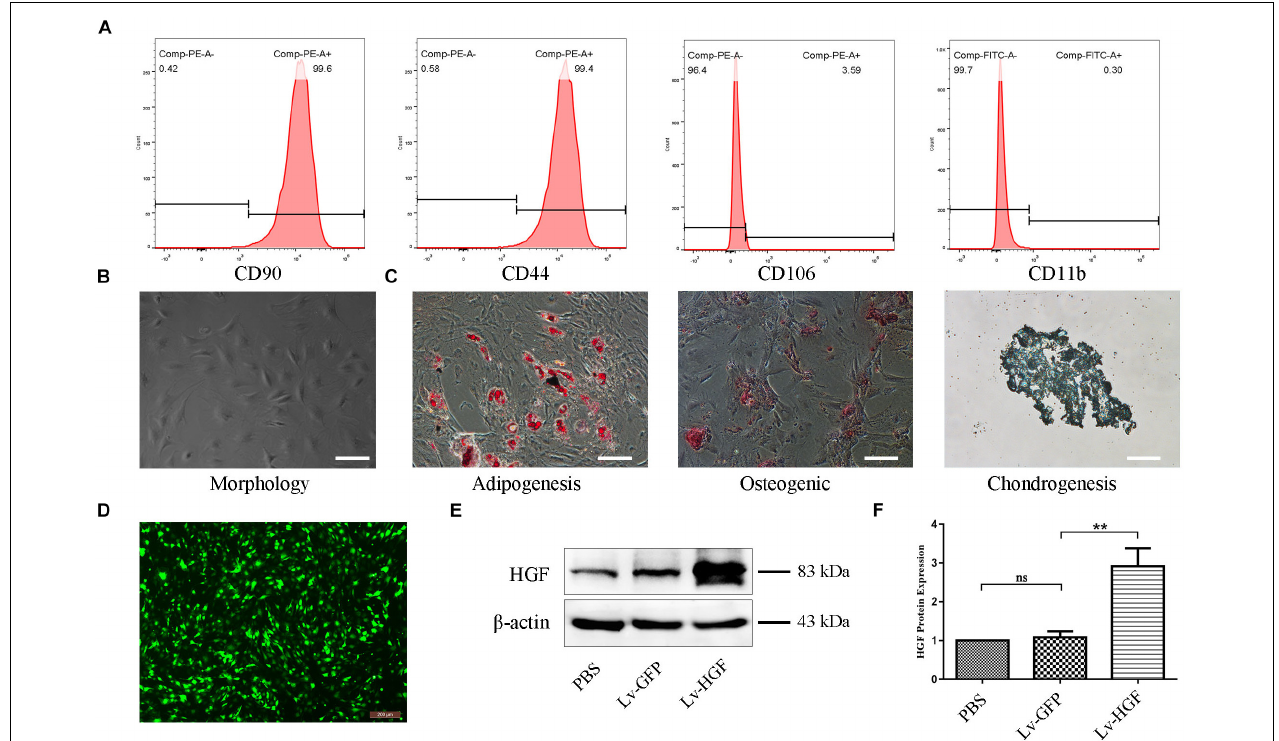
FIGURE 2 | Confirmation of TSC identity, differentiation capacity, and transduction efficiency. (A) Flow cytometric detection of cell surface markers, including CD90, CD44, CD106, and CD11b/c. (B) Typical TSC morphology. (C) Oil Red O, Alizarin Red, and Alcian Blue stains demonstrating TSC multilineage differentiation capacity. Scale bars: 100 µ m. (D) Fluorescent photomicrograph demonstrating examples of TSC morphology after HGF transduction and puromycin screening. (E,F) Western blot confirming HGF protein expression by TSCs following transduction. Data are expressed as means ± SD of three independent experiments; ** P <